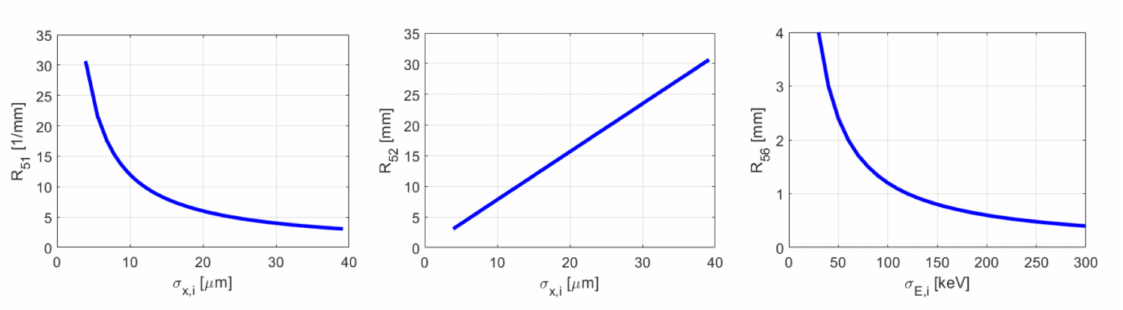
Figure 3. Maximum values for R 51, R 52 , and R 56 along the switchyard for a maximum bunch length variation of 0.1 µ m as functions of the initial beam size and energy spread at the beam energy level of 1